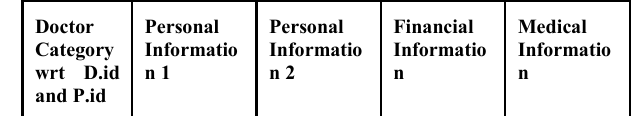
Table 5. Information